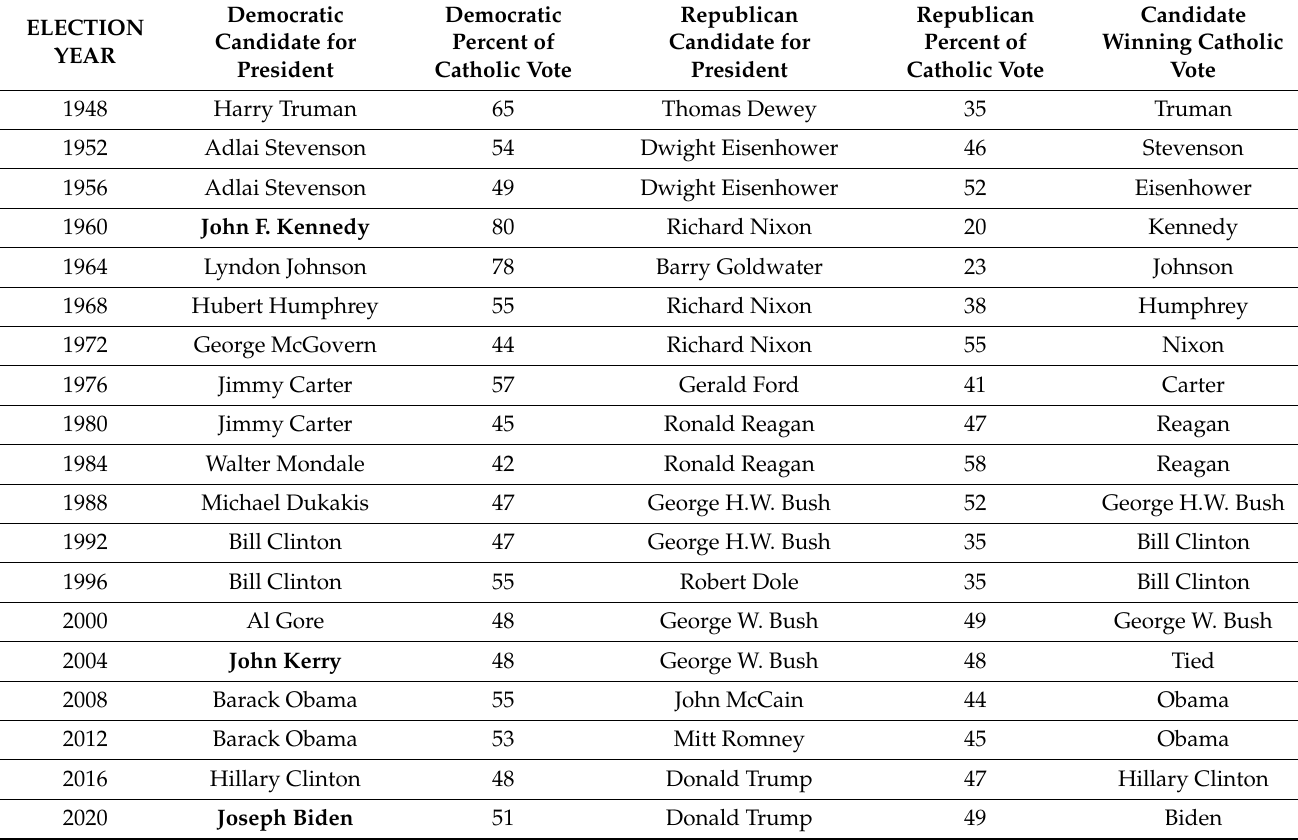
Table 1. Partisan Based Catholic Vote (Average of Polls), 1948–2020 (Catholic candidates are in